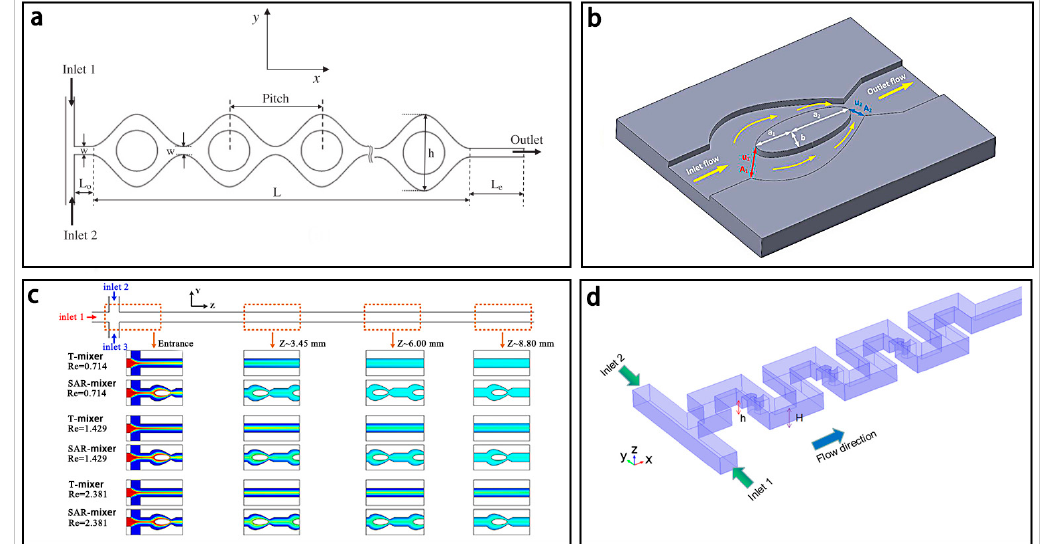
Figure 15. ( a ) Schematic of the convergence-divergence based micromixer with split-and-recombine structure; ( b ) Schematic of the convergence-divergence based micromixers with the ellipse-like micro-pillars; ( c ) Comparison of the mixing between the ellipse-like micro-pillars mixer and the T-channel mixer; ( d ) Schematic of the convergence-divergence based micromixers with two-dimensional serpentine channel and based on topology optimization method. Reproduced with permission from [103–105].